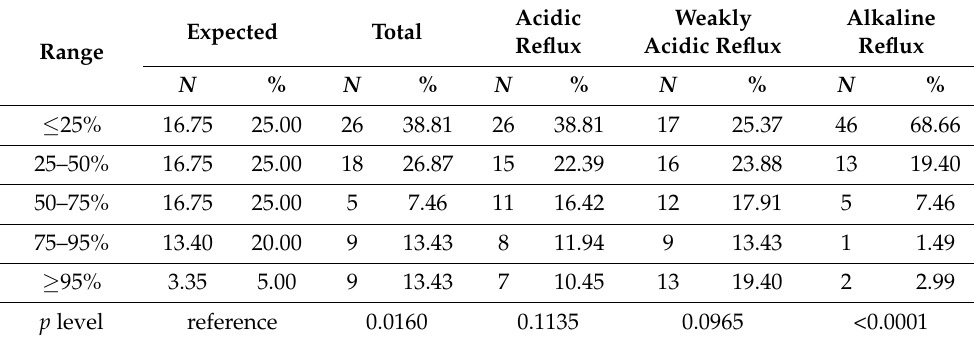
Table 3. Comparison of the number of different reflux episode types registered by MII-pH in patients with NI with the frequencies expected on the basis of the reference ranges defined by Zerbib